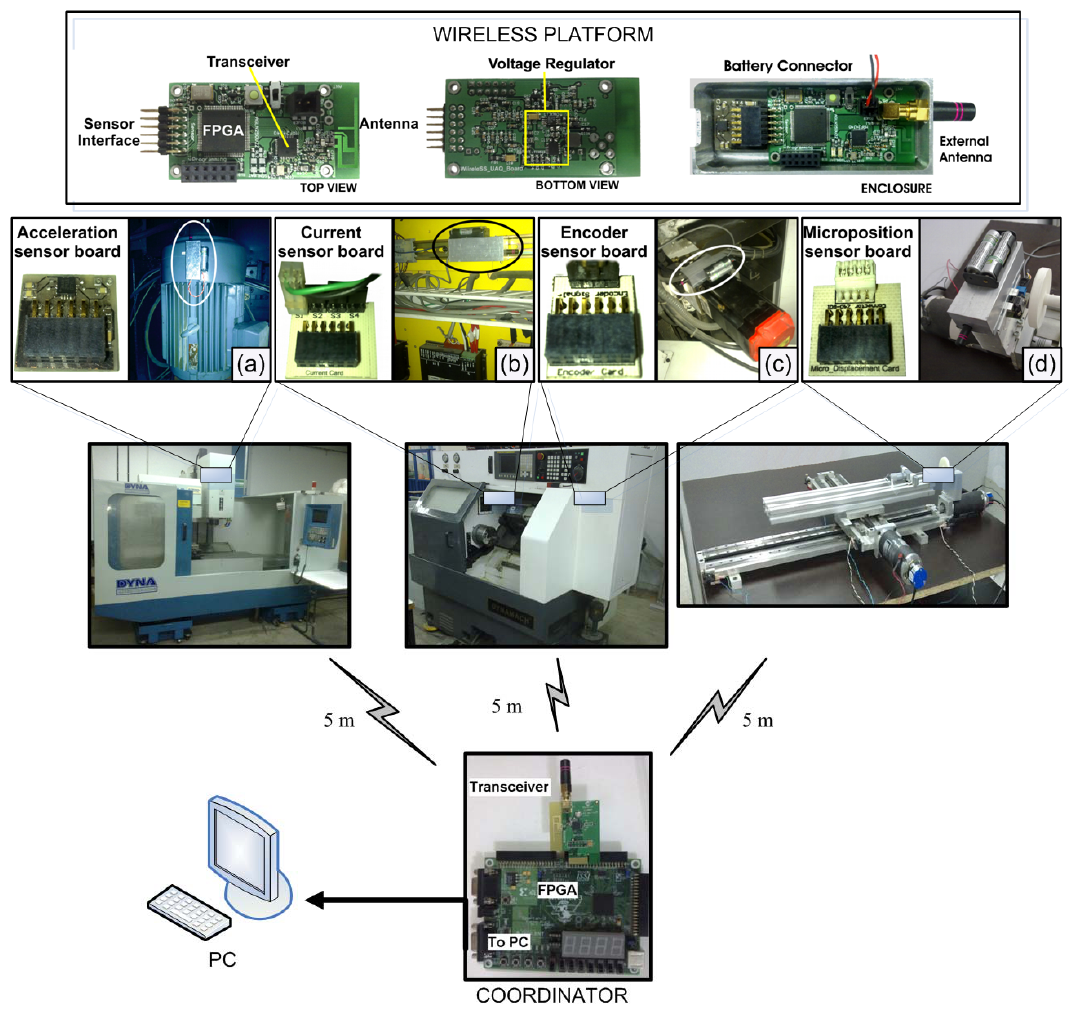
Figure 13. Experimental setup in a manufacturing cell, (a) vibration WSS mounting on the motor of DYNA-4M, (b) current WSS mounting on the FANUC Oi Mate-TC lathe panel, (c) (d) micropositioning WSS mounting on a two-axis linear stage.